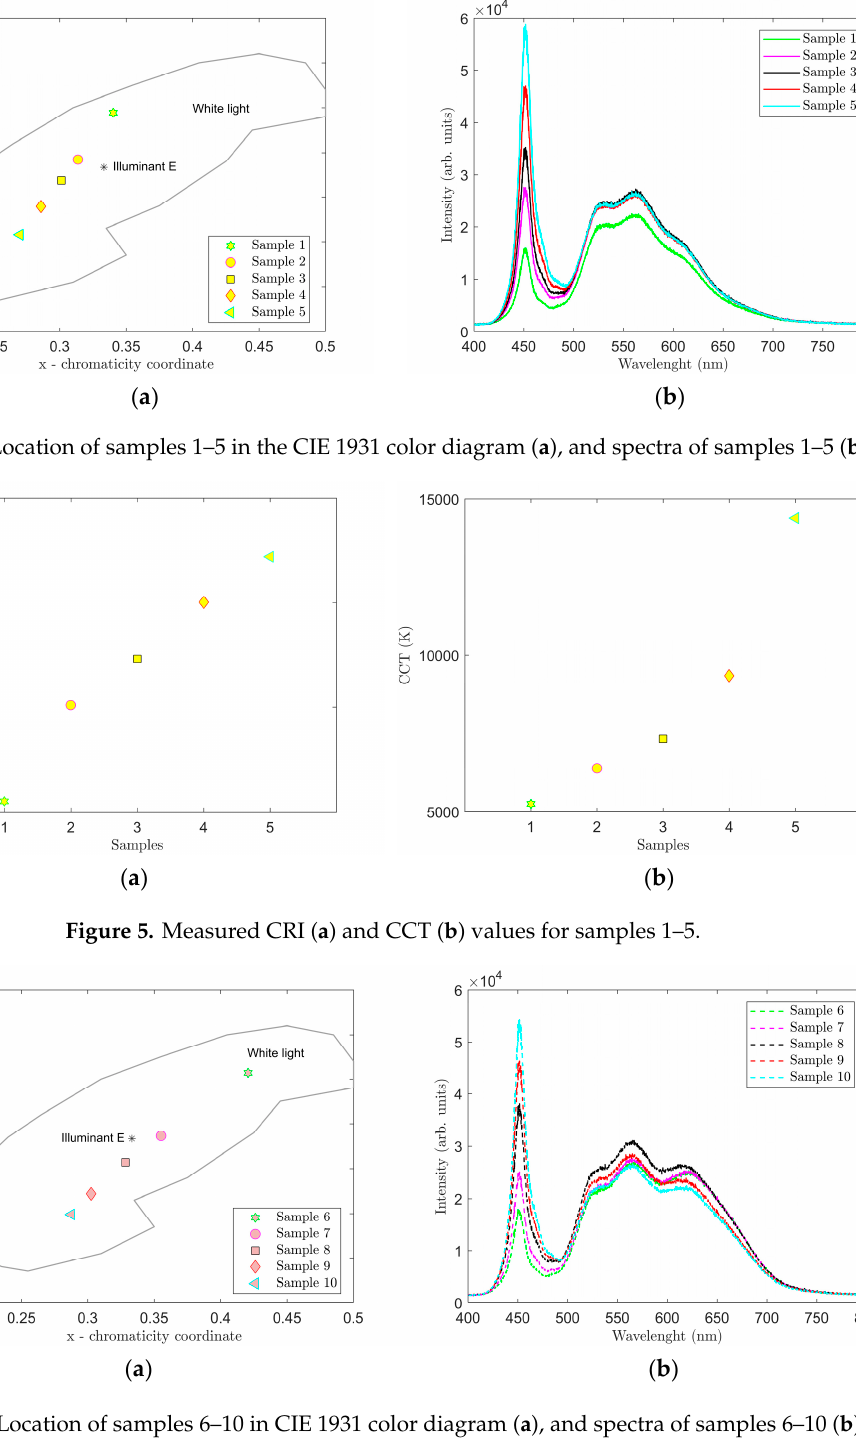
Figure 6. Location of samples 6–10 in CIE 1931 color diagram ( a ), and spectra of samples 6–10 ( b